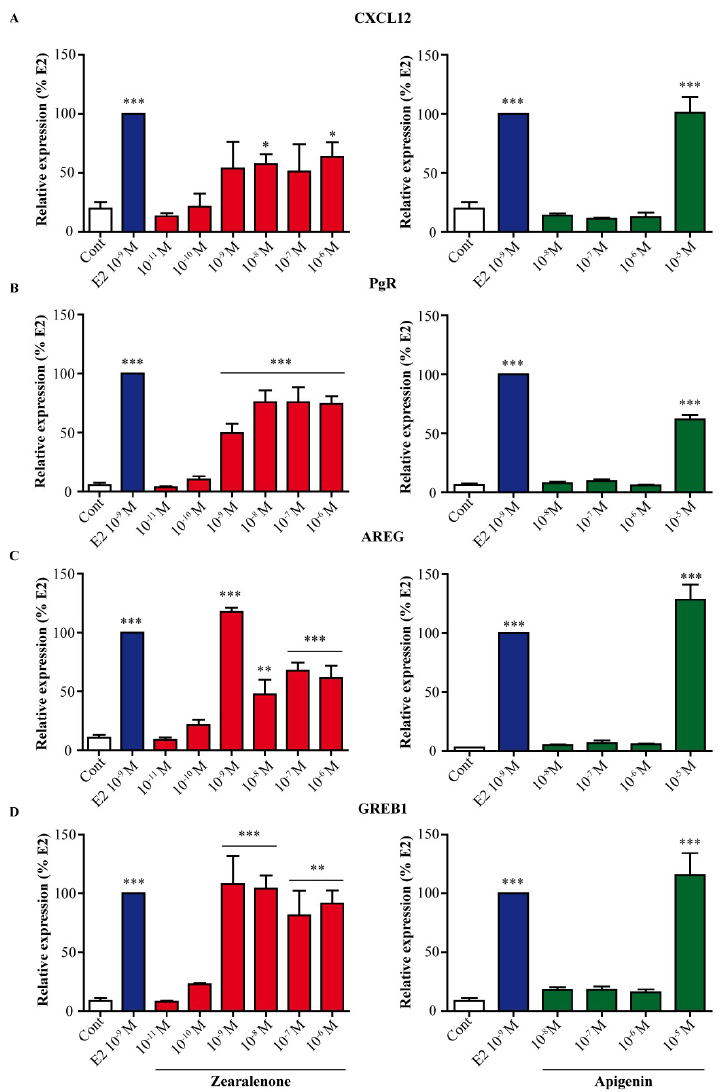
Figure 3. Effect of zearalenone and apigenin on the expression of endogenous E2 target genes. MCF- 7 cells were treated with solvent (white) as a negative control, 10 −9 M E2 (blue) as a positive control or with various doses of zearalenone (red) or apigenin (green) for 24 h. The expression of CXCL12 ( A ), PgR ( B ), AREG ( C ) and GREB1 ( D ) was assessed by real-time PCR. The expression level of each gene was normalized to the expression levels of the housekeeping genes GAPDH and TBP. The results are expressed as the percentage of the relative expression of transcripts obtained in E2-treated cells and are the means ± SEM of three independent experiments. * indicates a p -value < 0.05, ** indicates a p - value < 0.01, and *** indicates a p -value < 0.001 by one-way ANOVA followed by Dunnett’s post hoc test for comparison of the control treatment with the other